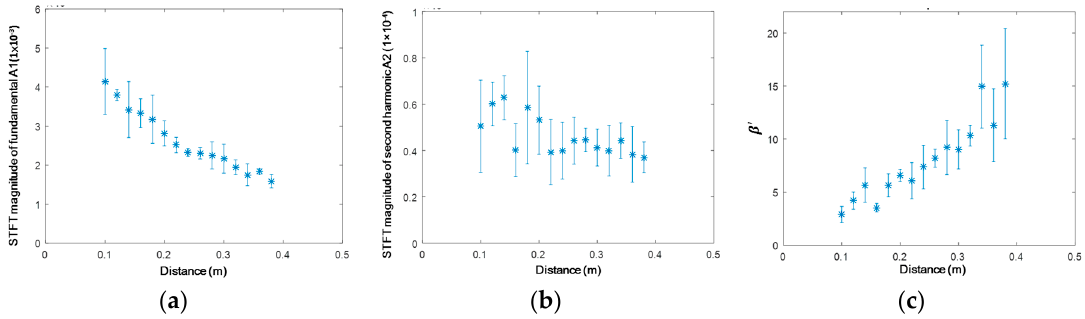
Figure 12. Signals of the mode pair S 1 -S 2 3.42 MHz mm–6.84 MHz mm at a propagation distance of 200 mm in the experiment (second harmonic mode × 20 times in amplitude). ( a ) Separated signals of the fundamental and second harmonic modes; ( b ) zoom-in signals of the S 1 and S 2 modes; and ( c ) separated energy packets of the S 1 and S 2 modes.